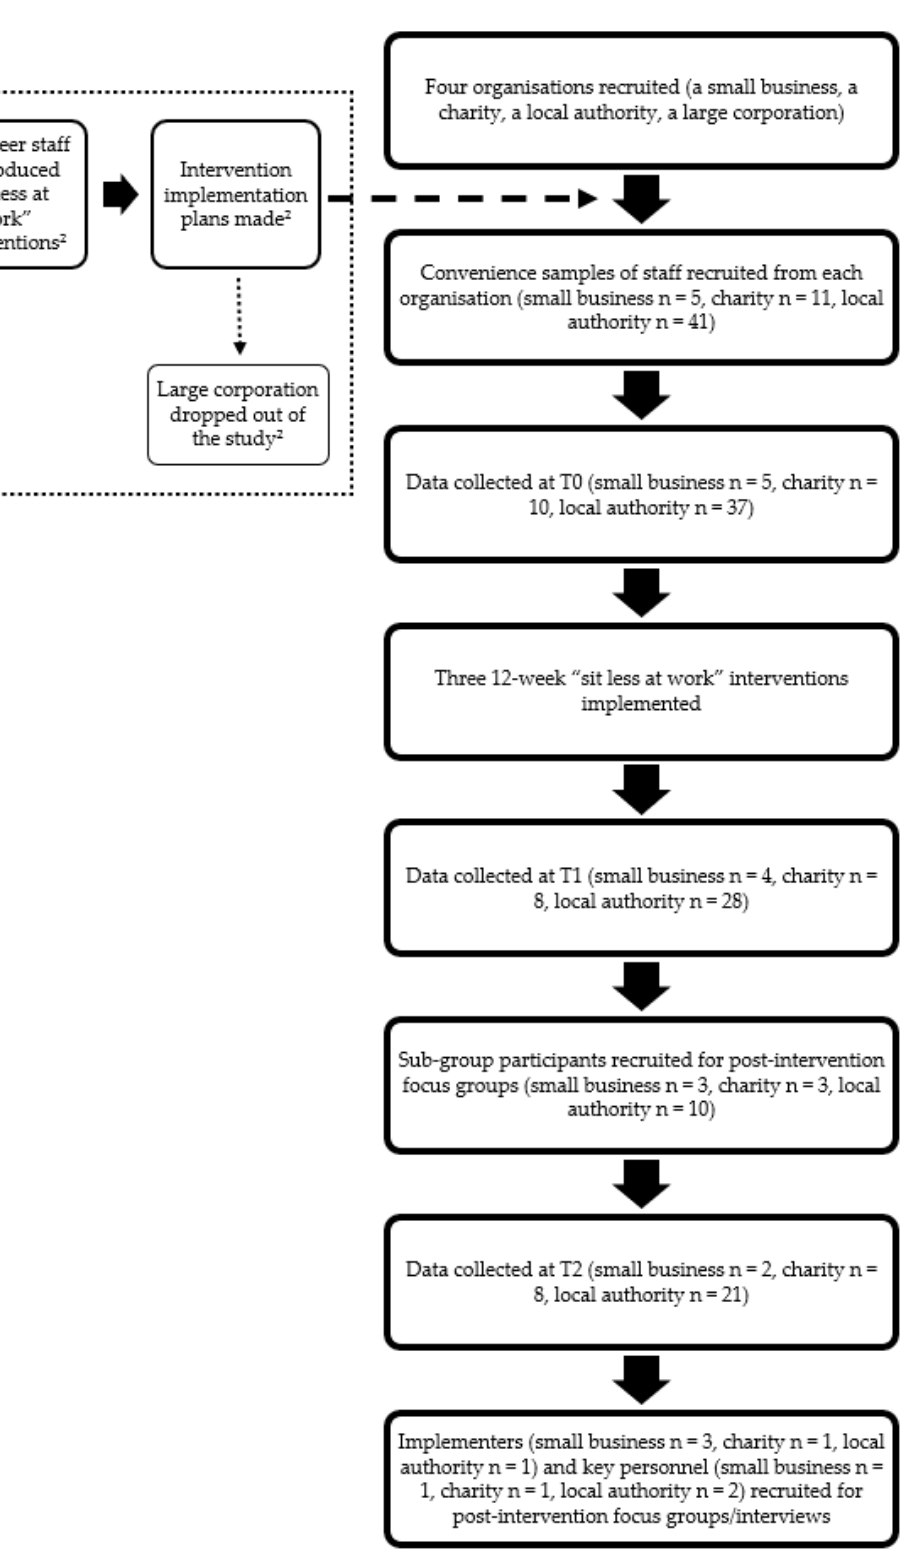
Figure 1. Flow chart of the research strategy. 1 Details pertaining to this part of the project are published elsewhere [29]. 2 Details pertaining to these parts of the project can be found in a linked paper also submitted to this Special Issue [34].